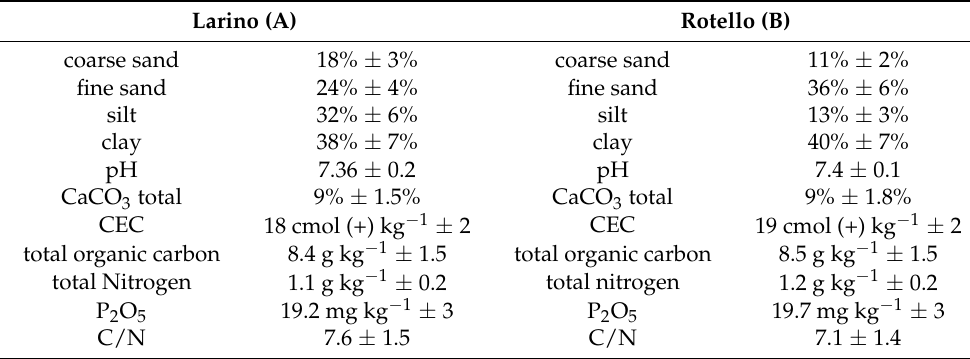
Table 4. Physico-chemical determinations of the soils of sites A and